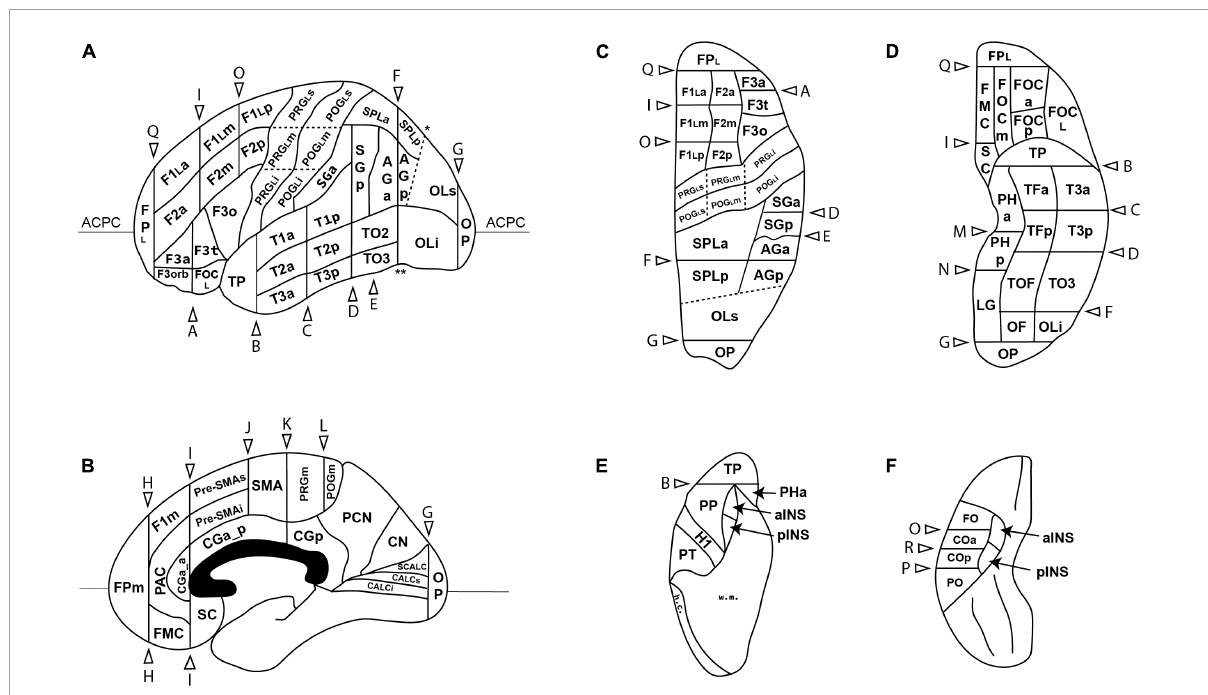
FIGURE1 Schematic diagram of the revised Harvard-Oxford Atlas parcellation of the human brain, hHOA2.0, from the lateral (A) , mid-sagittal (B) , superior (C) and inferior (D) perspectives. The opercular and insular surfaces of the Sylvian fissure are depicted from superior (E) and inferior (F) views that show the temporal opercular surfaces (E) and the frontal and parietal opercular surfaces (F) . Solid lines indicated by letters correspond to limiting planes. Curved lines represent sulci, and dotted lines represent non-sulcal or plane PU borders. The single asterisk in A is the superior location of the parieto-occipital sulcus, and the double asterisk is the pre-occipital notch. ACPC, anterior posterior plane; h.c., hemispheric convexity of parietal lobe; w.m., subcortical white matter. All other abbreviations are listed in Table 1 . Figure modified from Caviness et al.